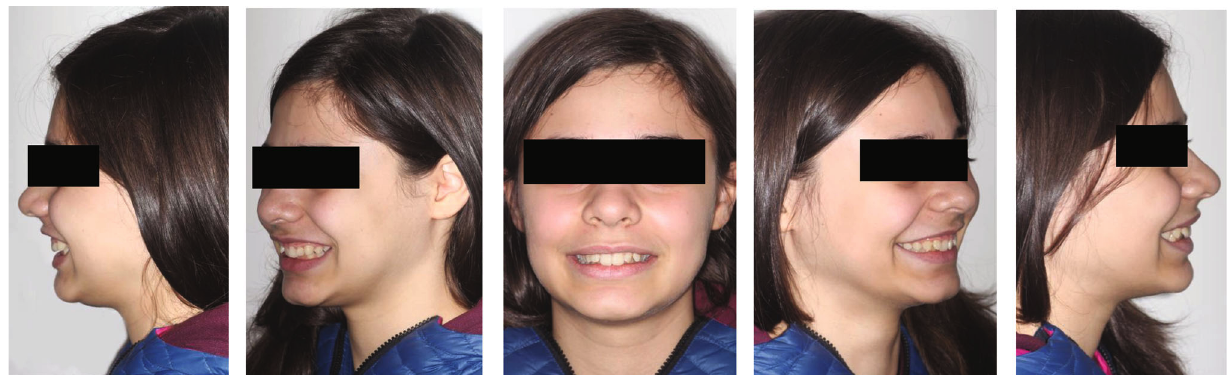
Figure 2: Pre-treatment extraoral photographs of smile.